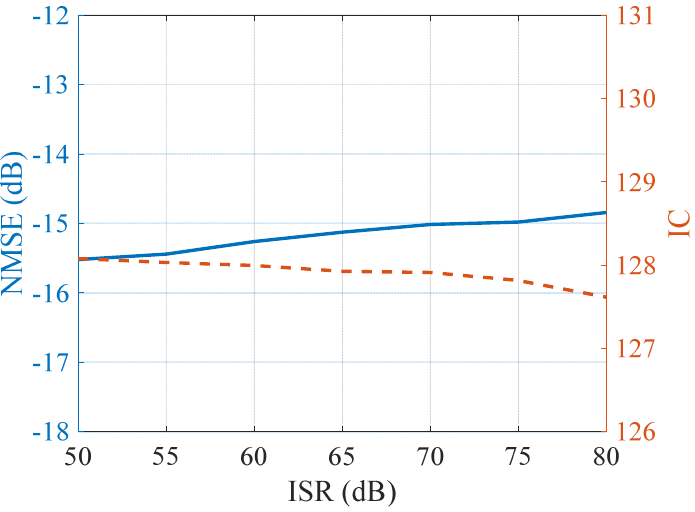
Figure 33. NMSEs and ICs of the real target images obtained by TSL0 after WDR under different ISRs with random WBI parameters.